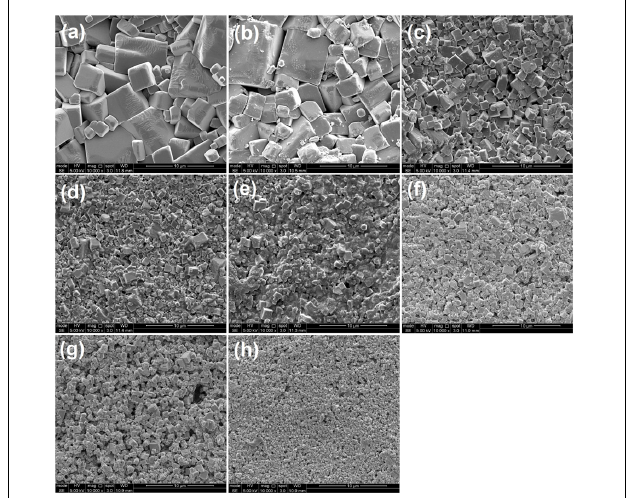
FIGURE 3 | SEM images of as sintered (1- x )K 0 . 4 Na 0 . 6 NbO 3 – x BiFeO 3 ( x = 1–3 mol.%) ceramics. Where (a) shows x = 0; (b) shows x = 0.5 mol.%; (c) shows x = 0.75 mol.%; (d) shows x = 1 mol.%; (e) shows x = 1.25 mol.%; (f) shows x = 1.5 mol.%; (g) shows x = 2 mol.%; and (h) shows x = 3 mol.%.